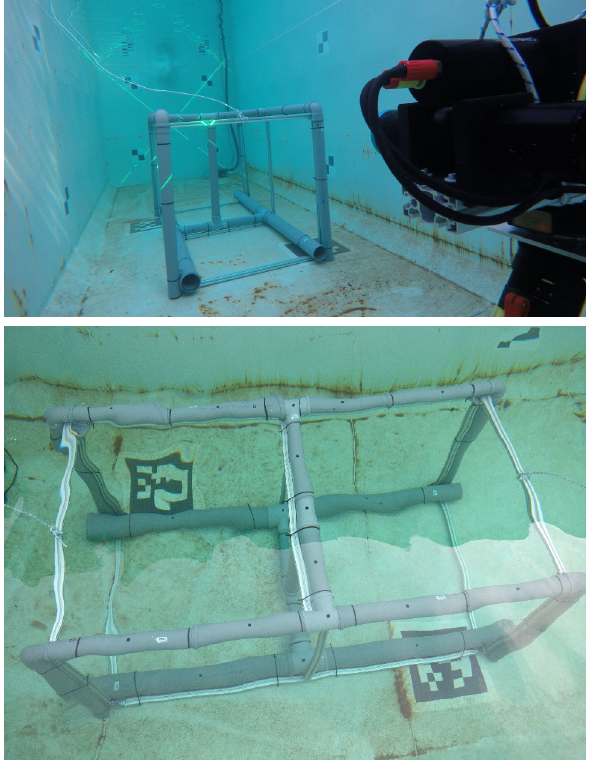
Figure 5. The first test structure placed in our water container. The size is 1 m × 1 m × 2 m and was build from item profiles and pipes.